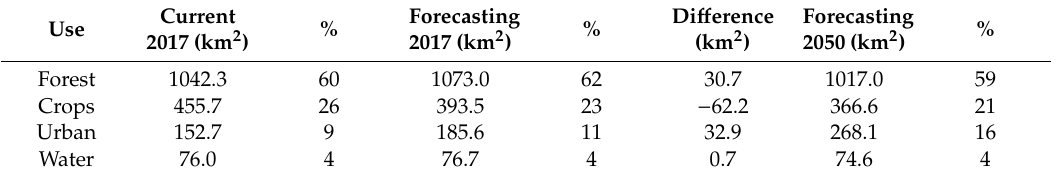
Table 6. Comparison between current land-use surface for 2017 and forecasting for 2017 and